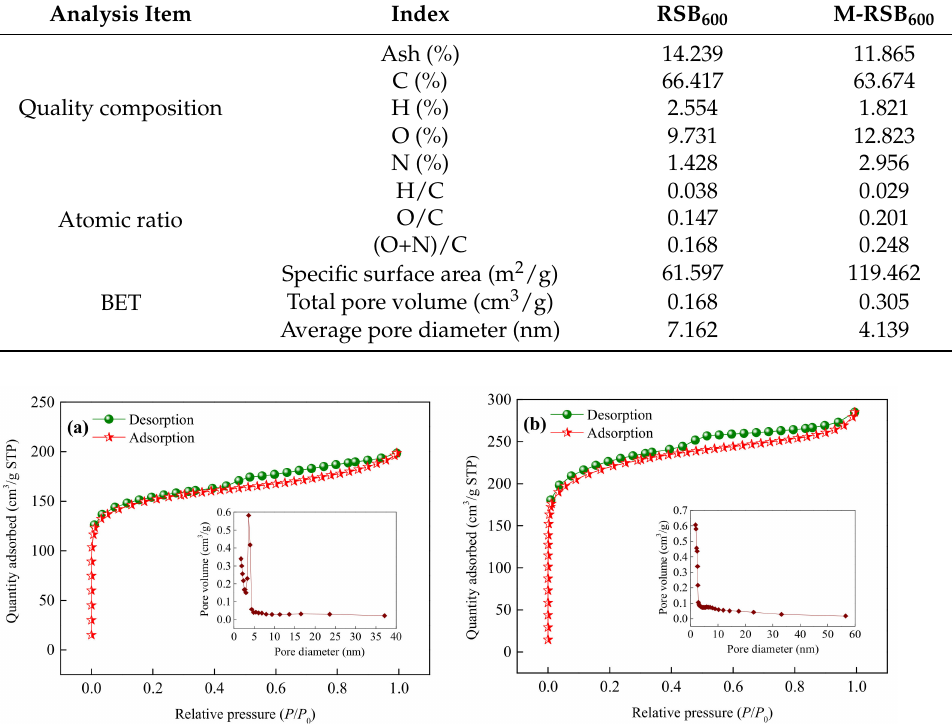
Table 2. The physicochemical properties of RSB 600 and M-RSB 600 .